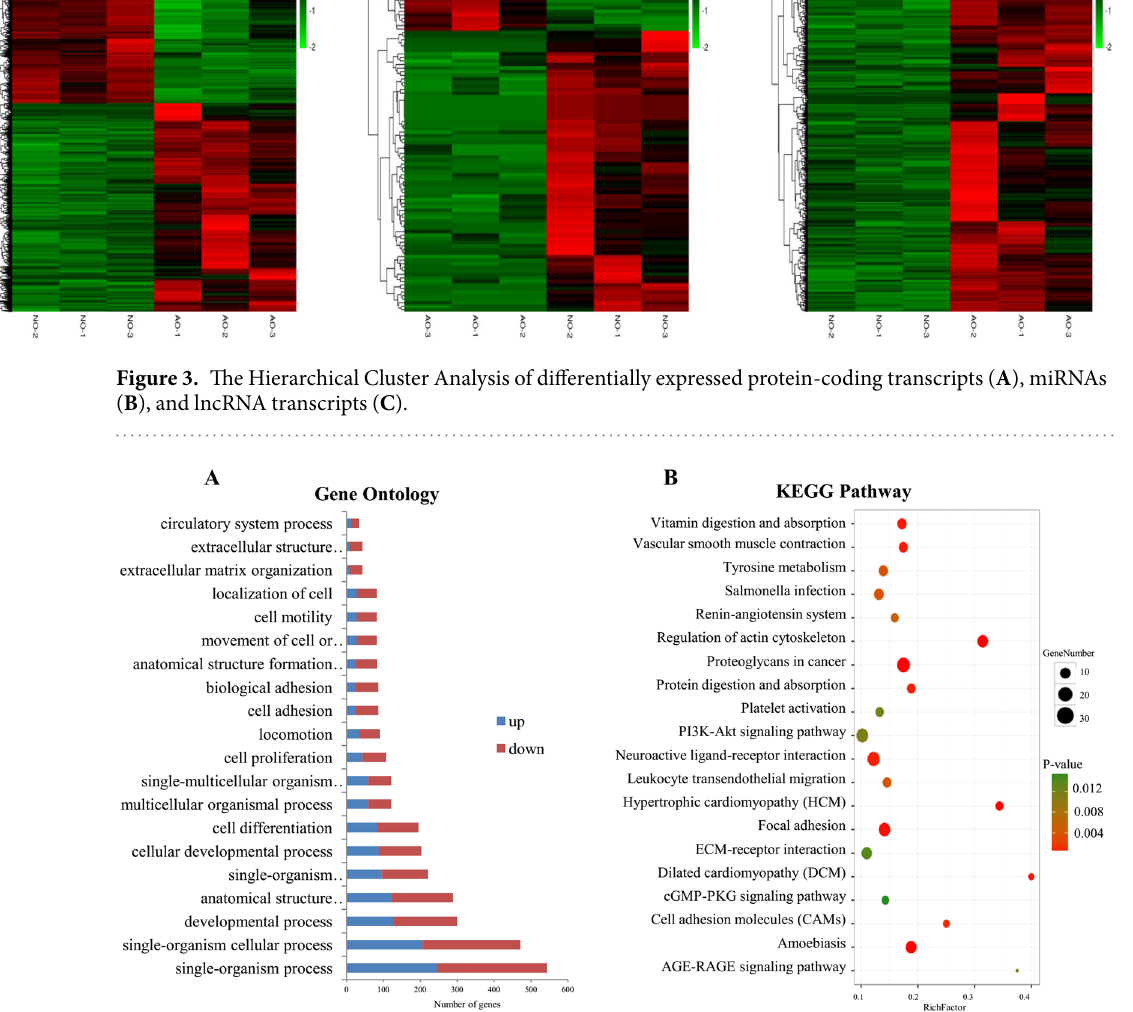
Figure 4. GO/pathway analysis of differentially expressed protein-coding transcripts. ( A ) Top 20 significantly changed GOs of protein-coding transcripts in biological processes; blue and kermesinus show up- and down- regulation in the atrophic ovary of broody chickens, respectively. ( B ) Top 20 significantly changed pathways associated with protein-coding